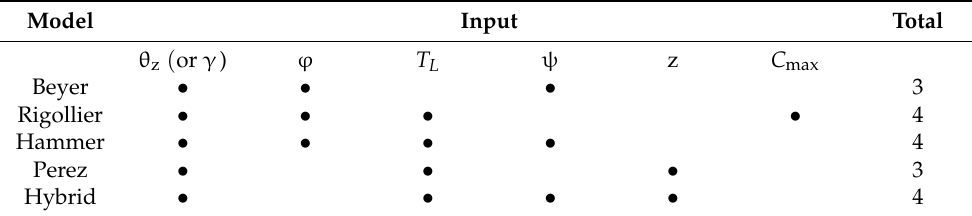
Table 5. Comparison of input variables in semi-empirical models.